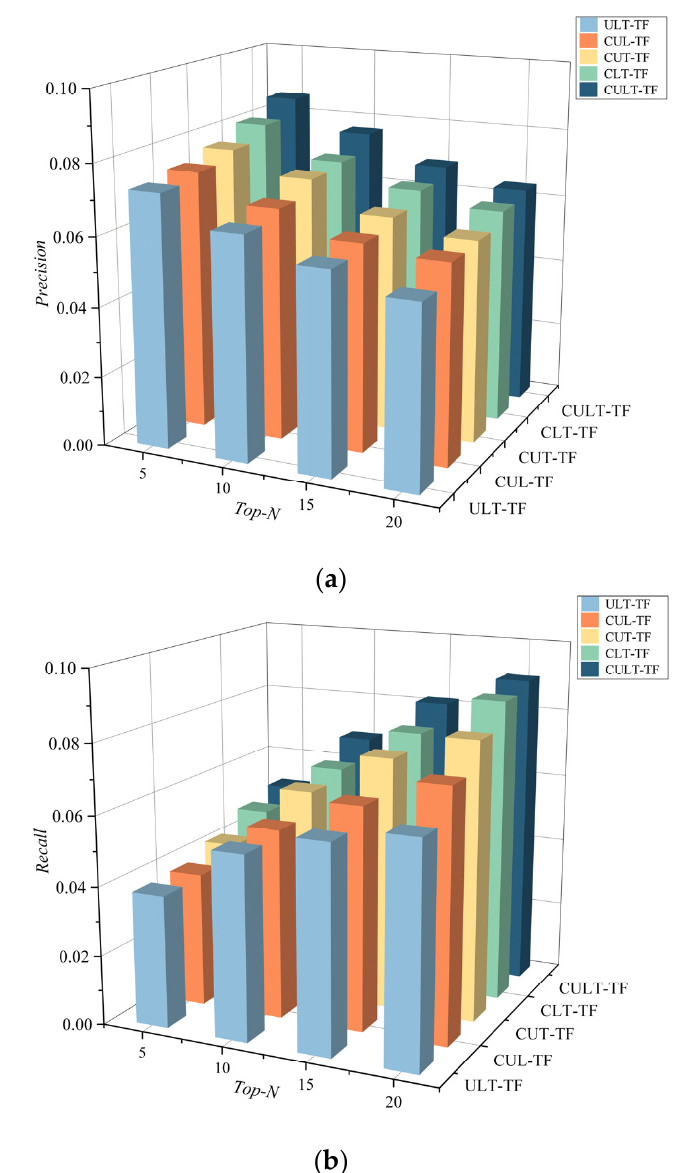
Figure 14. Recommendation accuracy of CULT-TF and four baseline methods. ( a ) Top-N Precision; ( b ) Top-N Recall. Table 6. Precision and recall of di ff erent baseline methods.